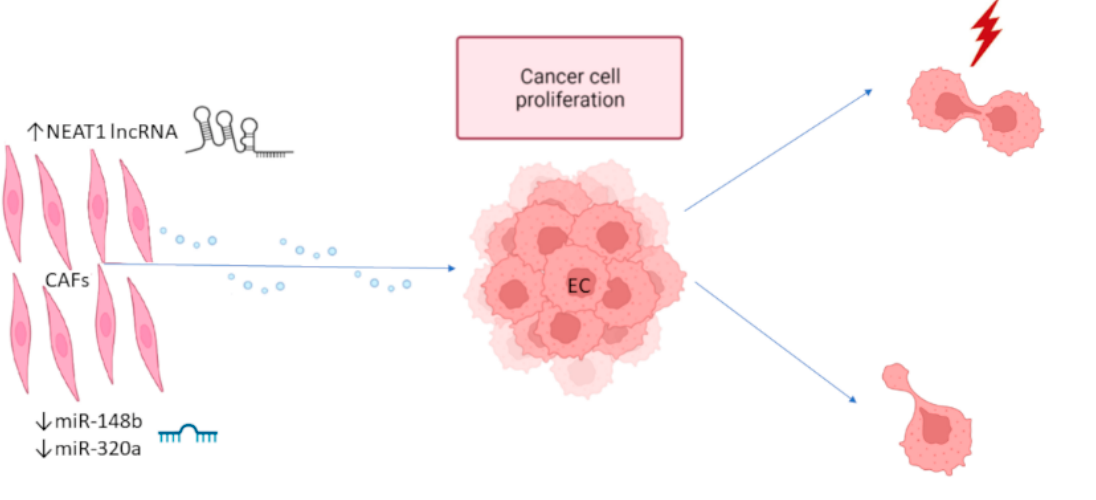
Figure 2. CAF-derived exosomes promote endometrial cancer growth. Exosomes derived from EC CAFs are enriched in lncRNA NEAT1 that has pro-oncogenic activity and is depleted in tumor suppressor miRNAs miR-148b and miR-320a. These CAF-derived exosomes are up-taken by EC cells, promoting EC cell proliferation, migration, and invasion, as well as resistance to irradiation. CAFs: cancer-associated fibroblasts; miRNA: microRNA; EC: endometrial cancer. The communication between EC cells and endometrial stromal cells is critical for EC cancer progression. FOXL2 was identified as one of the four Differentially Expressed Genes (DEGs) between EC and normal tissue samples [50]. FOXL2 is a tumor-suppressor gene whose expression is significantly downregulated in EC cell lines and EC samples. Low expression of FOXL2 in EC correlates significantly with poor prognosis. FOXL2 is targeted by miR-133a, amiRNA that is upregulated in EC samples and EC-derived exosomes that can be taken up by normal stromal cells. In this way, exosomal miR-133a mediates